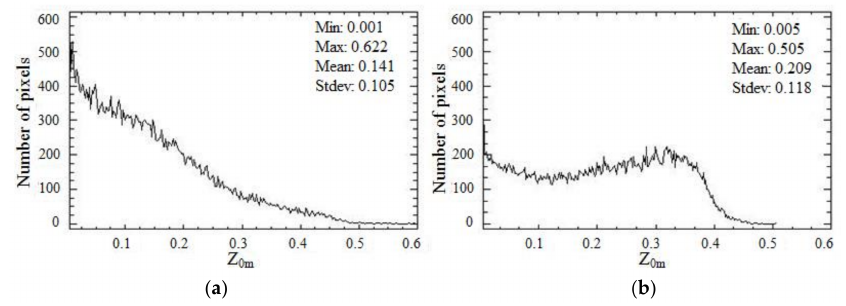
Figure 4. Number of pixels statistics of roughness length for momentum ( Z 0m ) ( a ) SEBAL, ( b ) SEBS.